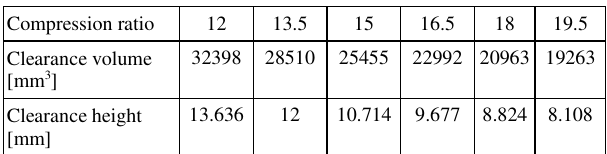
Fig. 3. Graph of piston motion profile Table 4. Variables of the model